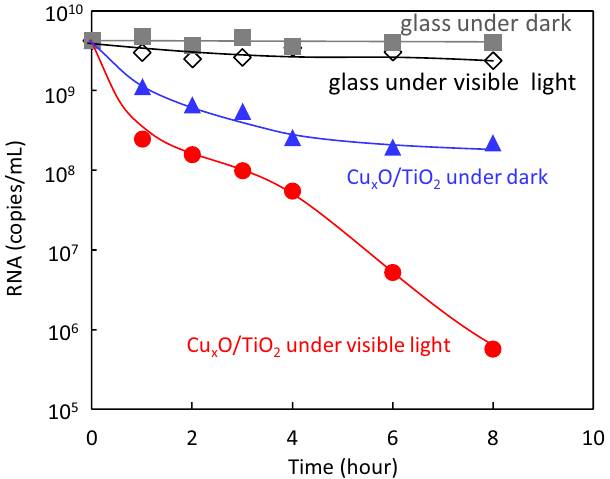
Figure 5. RT-qPCR analysis for SARS-CoV-2 N gene. Changes in RNA copies on glass and Cu x O/TiO 2 photocatalyst under visible light irradiation or dark condition. Visible light irradiation was conducted using a white fluorescence bulb passed through a UV cutoff filter with the light intensity of 1000 lx.